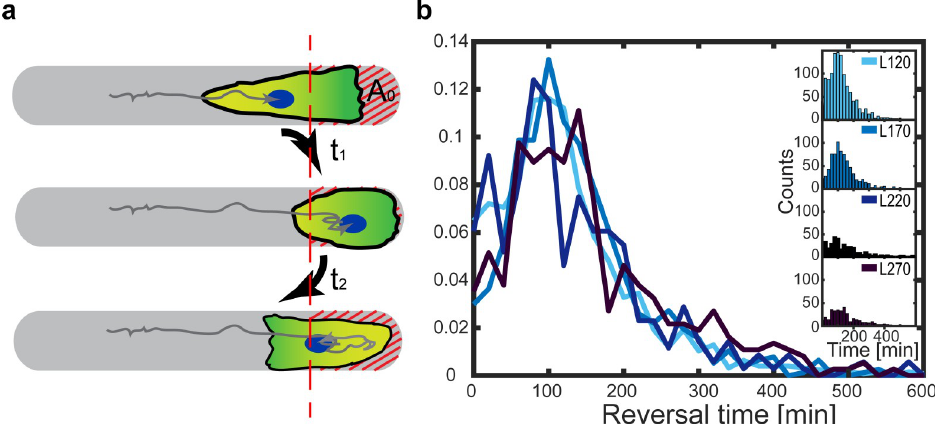
Fig 4. Distribution of “reversal times”. ( a ) Schematic drawing of a cell entering the microlane tip region A 0 (red hatches), arresting and then returning from the tip region, with the leading edge of the cell shaded in dark green. The red dashed line indicates the position of cell entry into the tip region A 0 , at time t 1 , and exit from the tip region, at time t 2 . ( b ) Normalized distribution of the reversal times t R = t 2 − t 1 for four different microlane lengths. Inset: Non- normalized (counts) distribution of the reversal